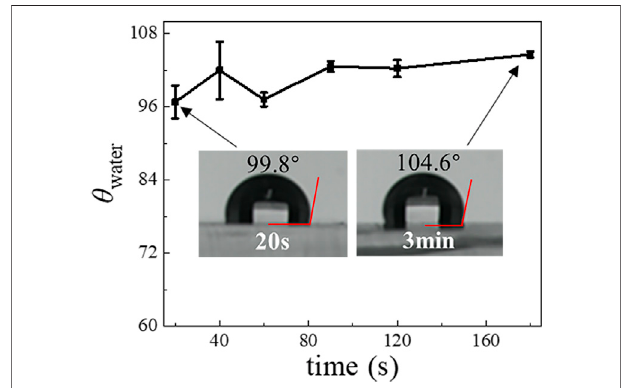
FIGURE 3 | The θ water of a PDMS surface with different Aquapel- treatment times.